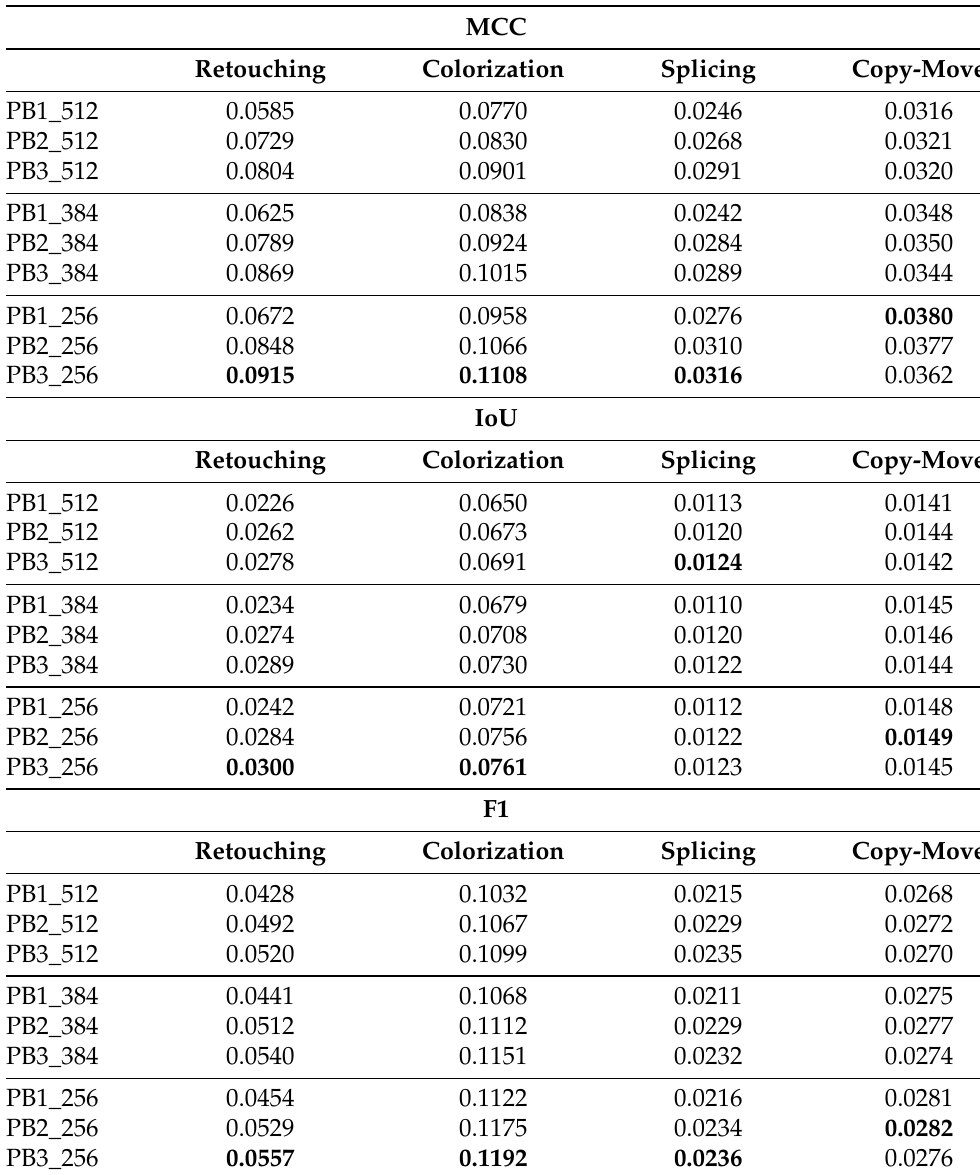
Table A1. MCC, IoU and F1 and scores for our method with one scale (PB1), two scales (PB2) and three scales (PB3) and considering different macroblock sizes: 512, 384 and